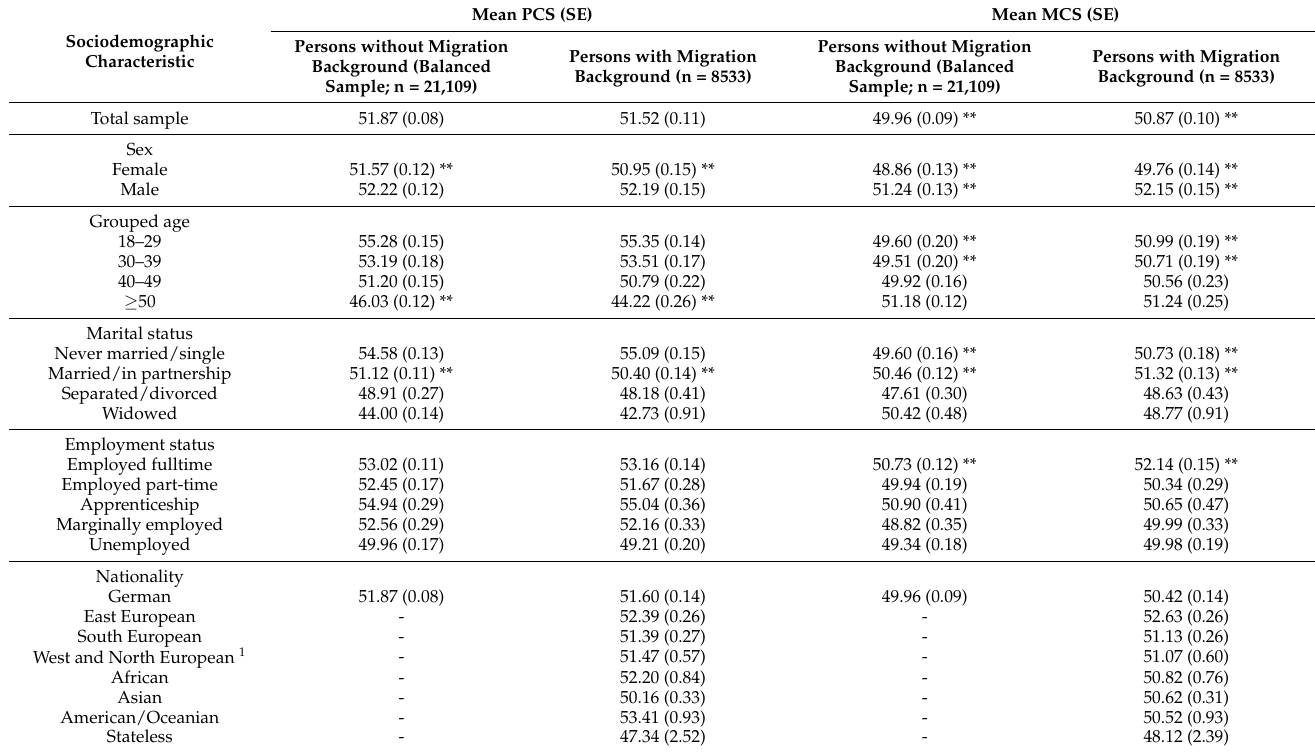
PCS: Physical Component Summary; MCS: Mental Component Summary; SE: standard error; comparison of mean PCS and MCS scores by migration background were analyzed using Student’s t -test; 1 without German nationality; ** p ≤